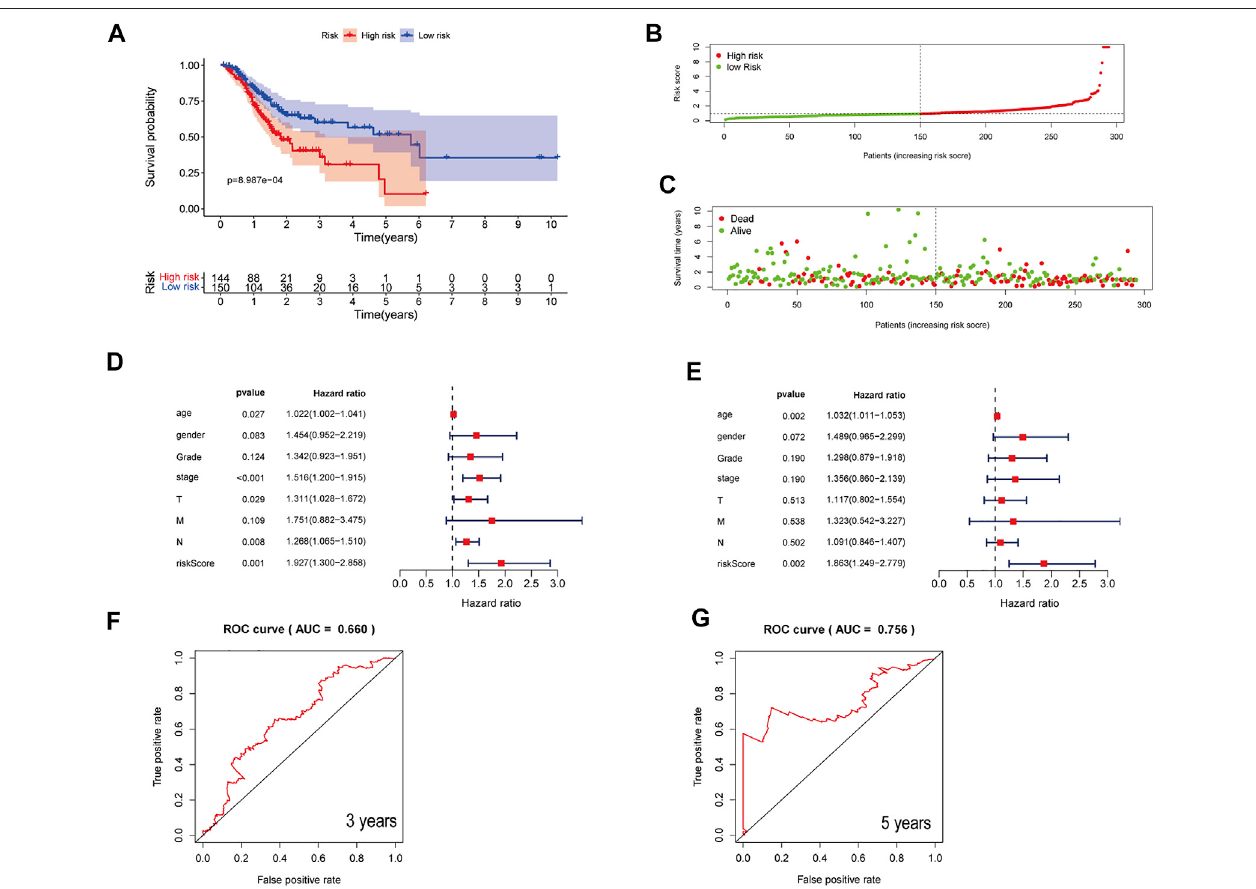
FIGURE 3 | Assessment of a three-ferroptosis-related-lncRNA model for predicting prognosis of STAD in the entire dataset. (A) Kaplan – Meier curves of the high- risk and the low-risk groups in the entire dataset. (B) The distribution of patients in different risk groups. (C) Survival status of patients in the high-risk and the low-risk groups. (D) A forest plot of univariate Cox regression analysis in the entire dataset. (E) A forest plot of multivariate Cox regression analysis in the entire dataset. (F, G) Three- and 5-year ROC curves illustrating the predictive accuracy of the model for prognosis in the entire